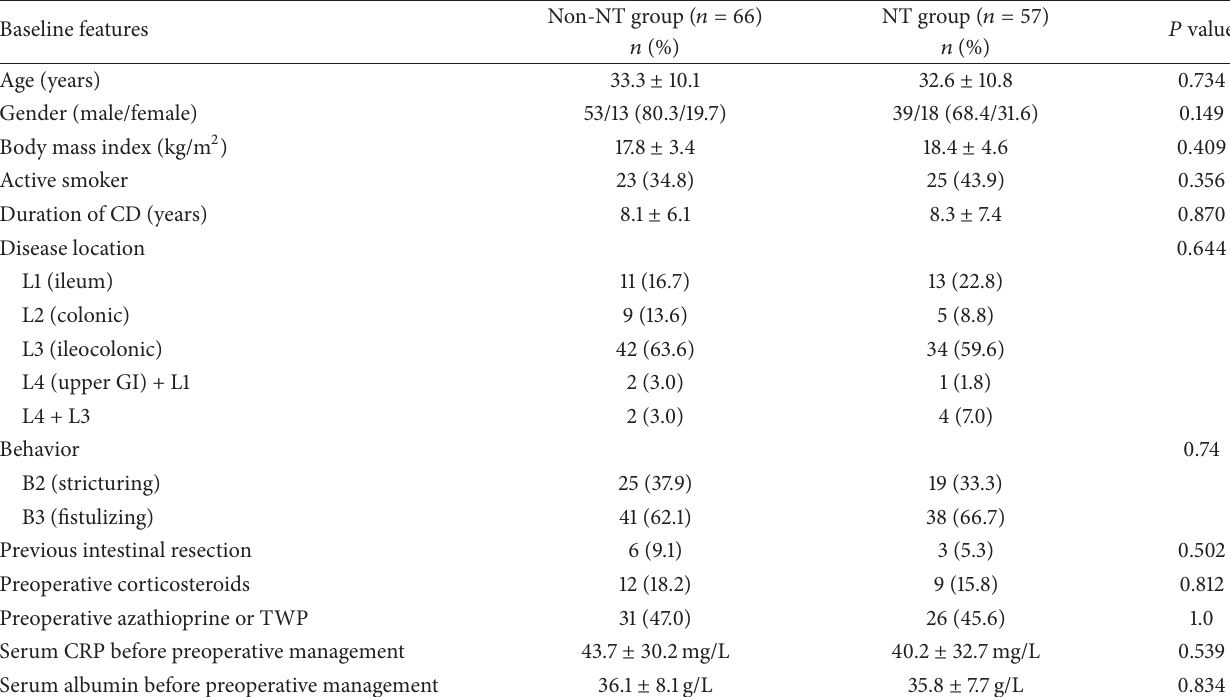
Table 1: Patients characteristics.